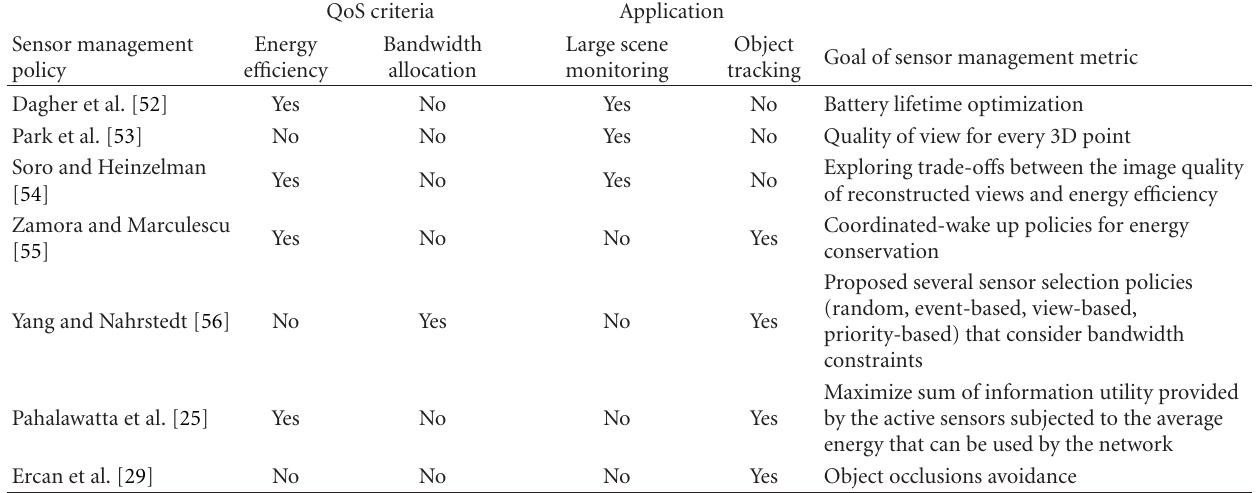
Table 3: Comparison of sensor management